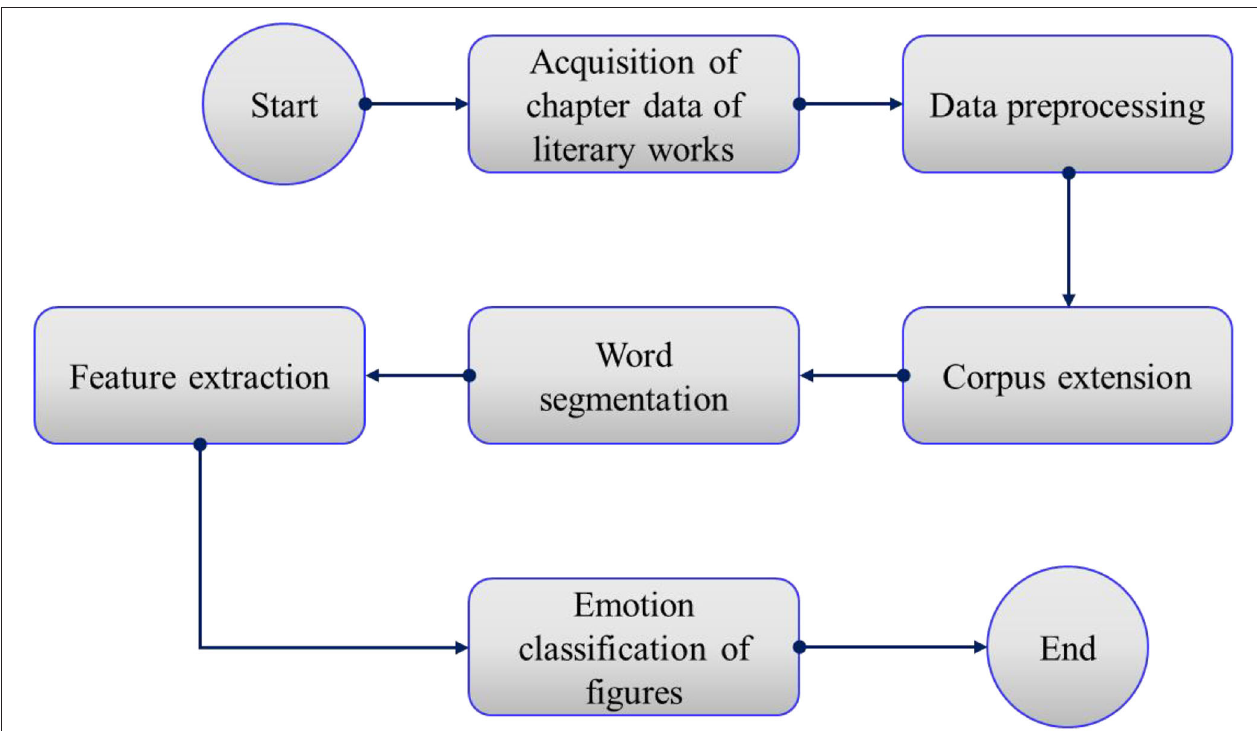
FIGURE 1 | Classification process of figures’ emotions in literary works based on the extended